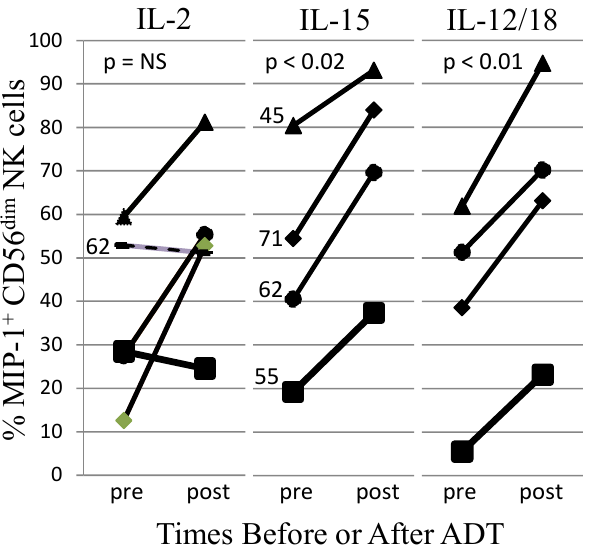
Figure 2. Blood from five patients was studied before and 92–96 days (or 51 days in one patient shown as a dashed line in IL-2 panel) after the start of ADT, which included Lupron ® , with or without additional ADT drugs. In all cases, short-term Casodex ® pre-treatment was used to prevent a Lupron-associated testosterone flare. Peripheral blood mononuclear cells were stimulated for 20 h with IL-2 (200 U/mL), IL-15 (100 ng/mL), or IL-12/IL-18 (10/100 ng/mL), as indicated above each panel. The cells were harvested and NK cell intracellular MIP-1β was measured by flow cytometry, using standard methods [156]. Shown are responses by mature CD56 dim NK cells. Each symbol represents responses by the same patient and patient age is indicated in the panels. Significance was assessed by paired student’s t -test. NS = not significant.